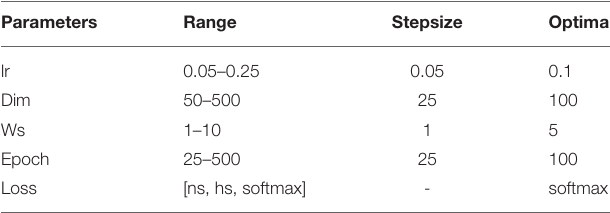
TABLE 1 | Hyperparameters chosen for tuning FastText model.